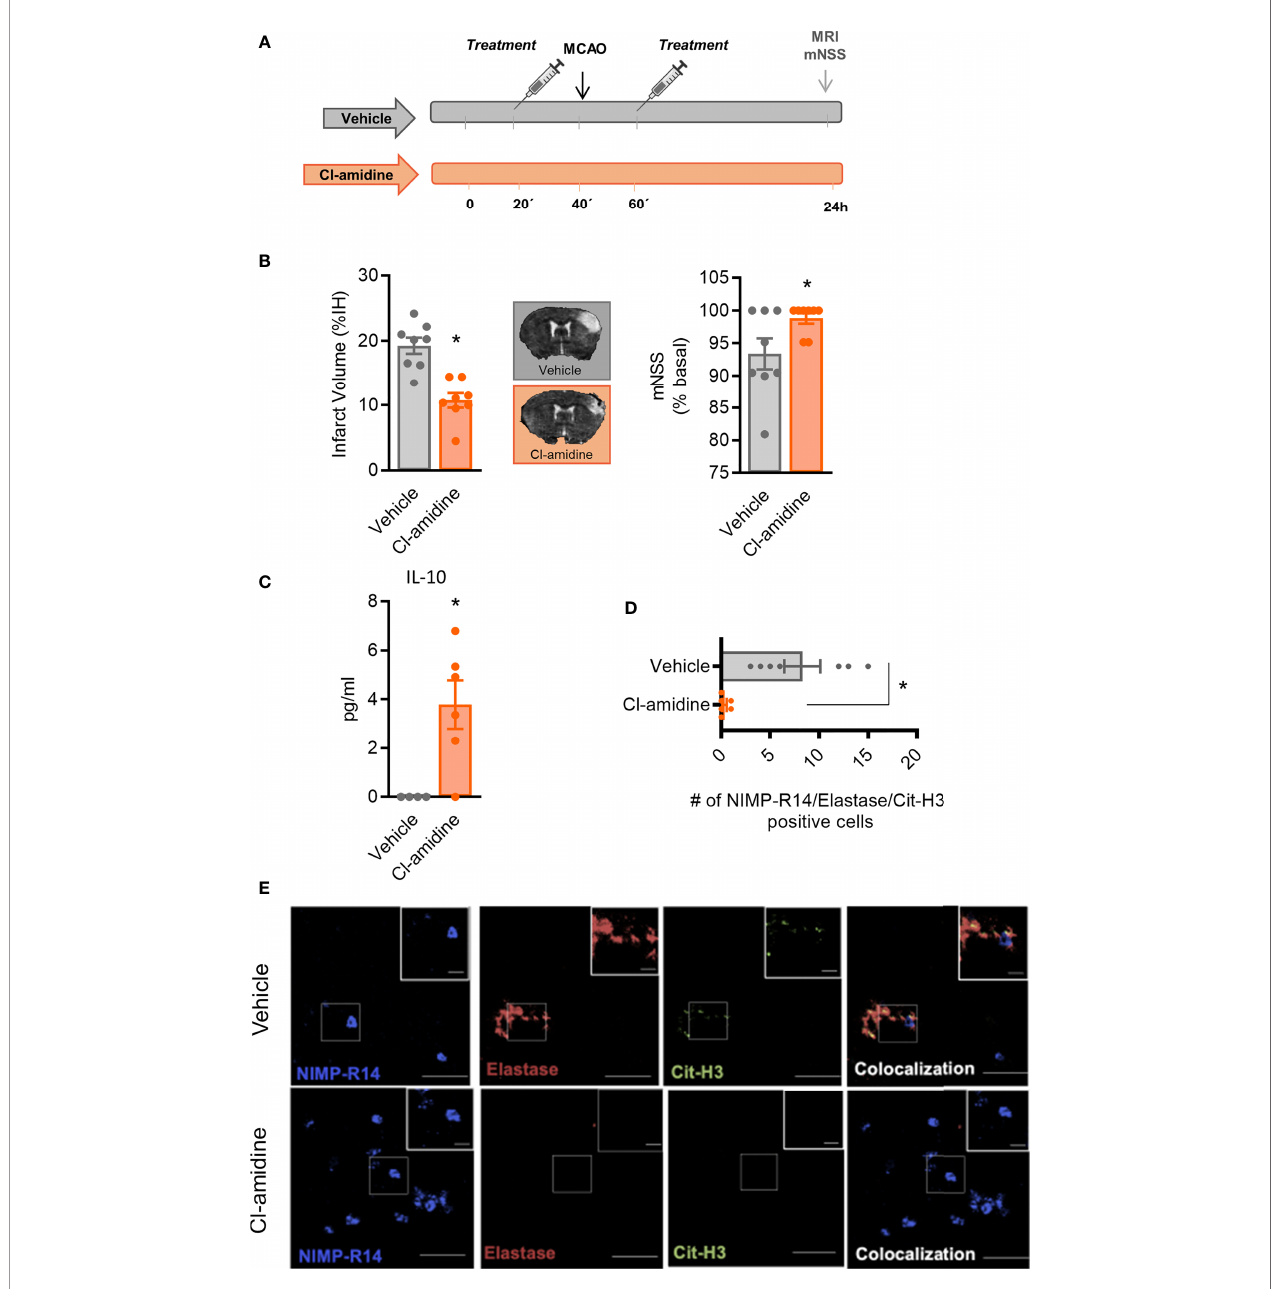
FIGURE 4 | Effect of Cl-amidine treatment after stroke. (A) Design of the study. (B) Infarct volumes determined 24 hours after the occlusion. (C) Effect of Cl-amidine on plasma concentration of IL (interleukin)-10 24 hours after the occlusion. (D) Number of NIMP-R14, elastase and Cit-H3-positive cells. (E) Representative images. Data are mean± SEM (n = 4-8 *p < 0.05 vs